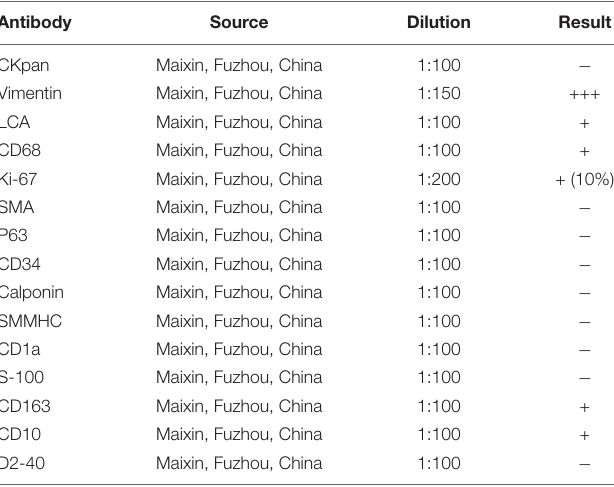
TABLE 1 | A summary of the primary antibodies used and the results of immunohistochemistry. Antibody Source Dilution